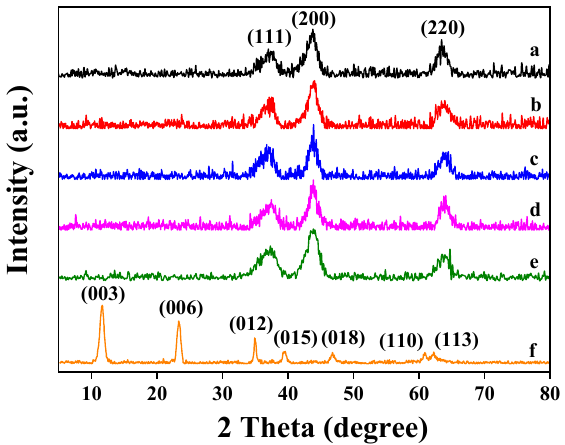
Figure 2. XRD patterns of Ni 1.5 Co 0.5 Al-LDH precursor and the Pt n /Ni 1.5 Co 0.5 AlO catalysts: (a) Ni 1.5 Co 0.5 AlO; (b) Pt 1 /Ni 1.5 Co 0.5 AlO; (c) Pt 2 /Ni 1.5 Co 0.5 AlO; (d) Pt 4 /Ni 1.5 Co 0.5 AlO; (e) Pt 6 /Ni 1.5 Co 0.5 AlO; (f) Ni 1.5 Co 0.5 Al-LDH.